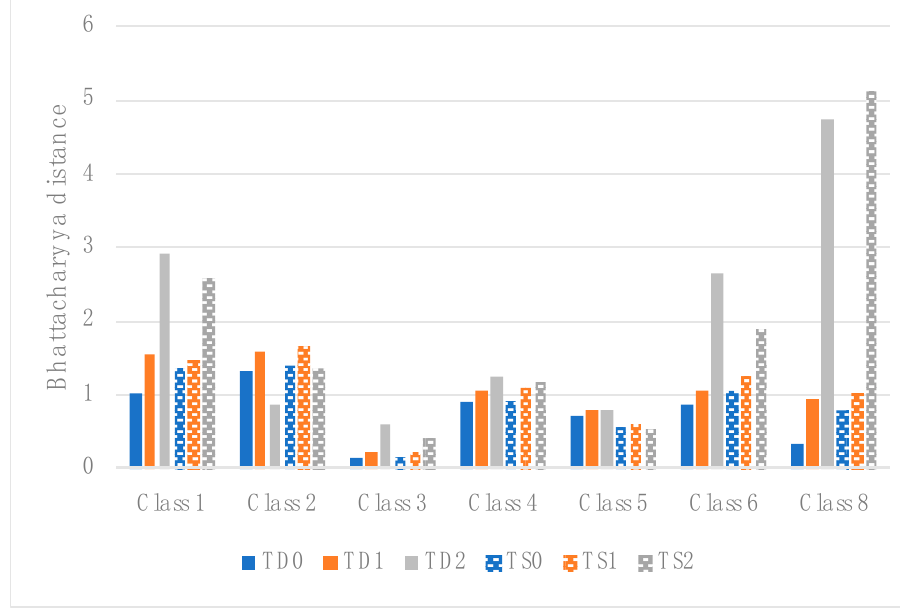
Figure 10. Class separability per class for the TD0, TD1 and TD2 datasets and the samples TS0, TS1 and TS2 extracted from these datasets to train the classifier for study area B.